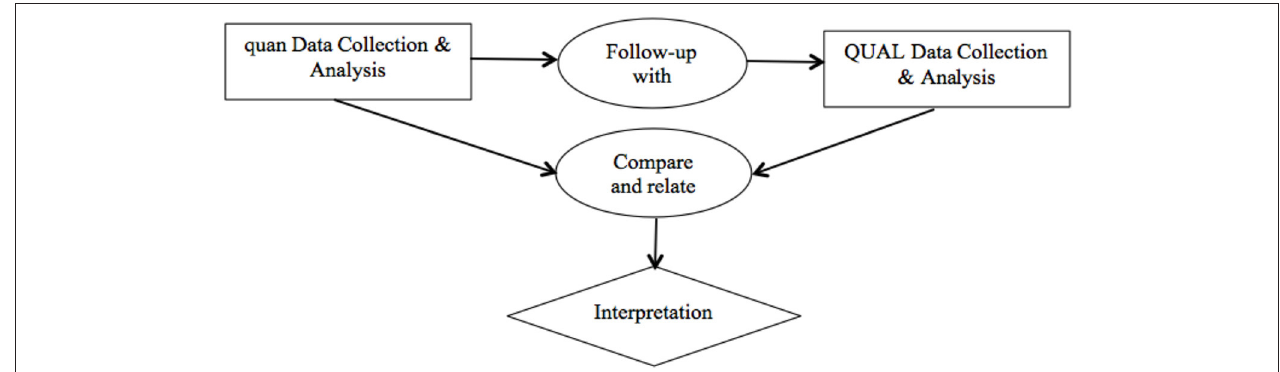
FIGURE 1 | Visual representation of the concurrent sequential mixed method research